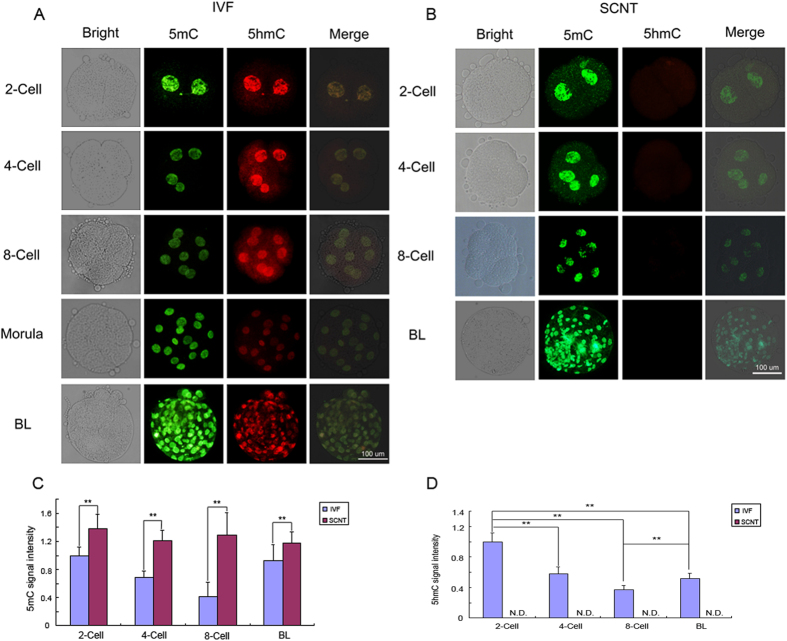
Immunofluorescent (IF) staining of 5-mC and 5-hmC in bovine oocytes and IVF and SCNT preimplantation embryos.(A) The distribution of 5-mC (red) and 5-hmC (green) in bovine IVF preimplantation embryos. (B) The distribution of 5-mC and 5-hmC in bovine SCNT preimplantation embryos. (C,D) The 5-mC and 5-hmC signal intensities were measured in at least 5 embryos at each developmental stage. The signal intensity in IVF 2-cell embryos was used as a calibrator sample (set to 1). The results represent the mean ± standard deviation of five independent experiments. **P < 0.01. BL: IVF blastocysts.